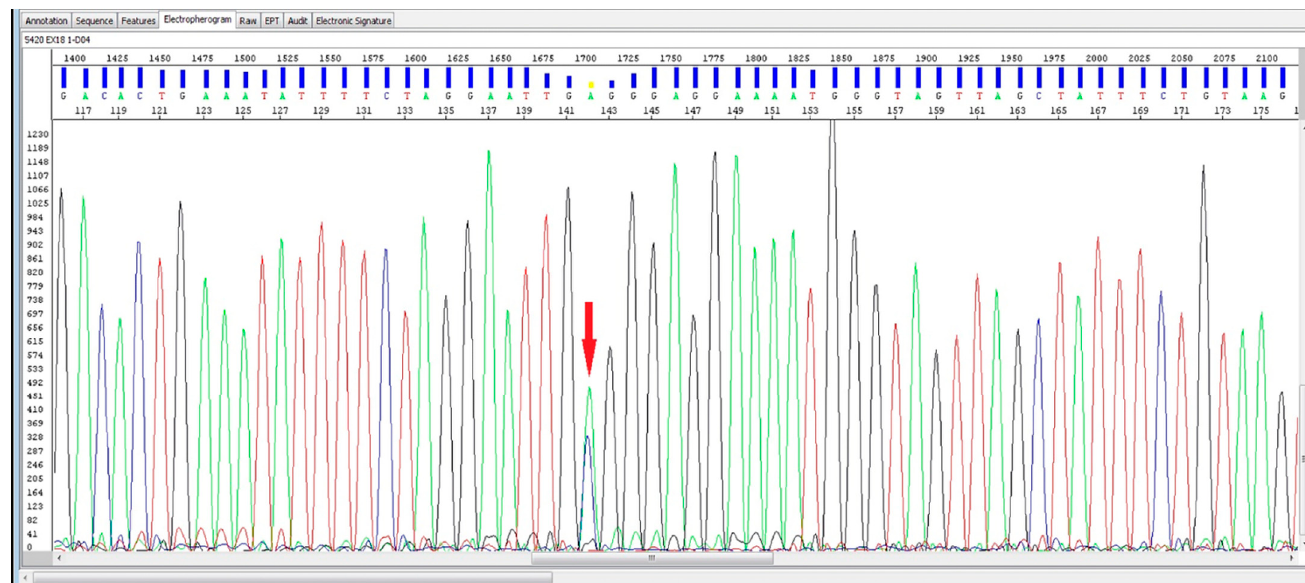
Figure 3. BRCA2 gene mutation in AVPCa (red arrow indicates the BRCA2 defect)